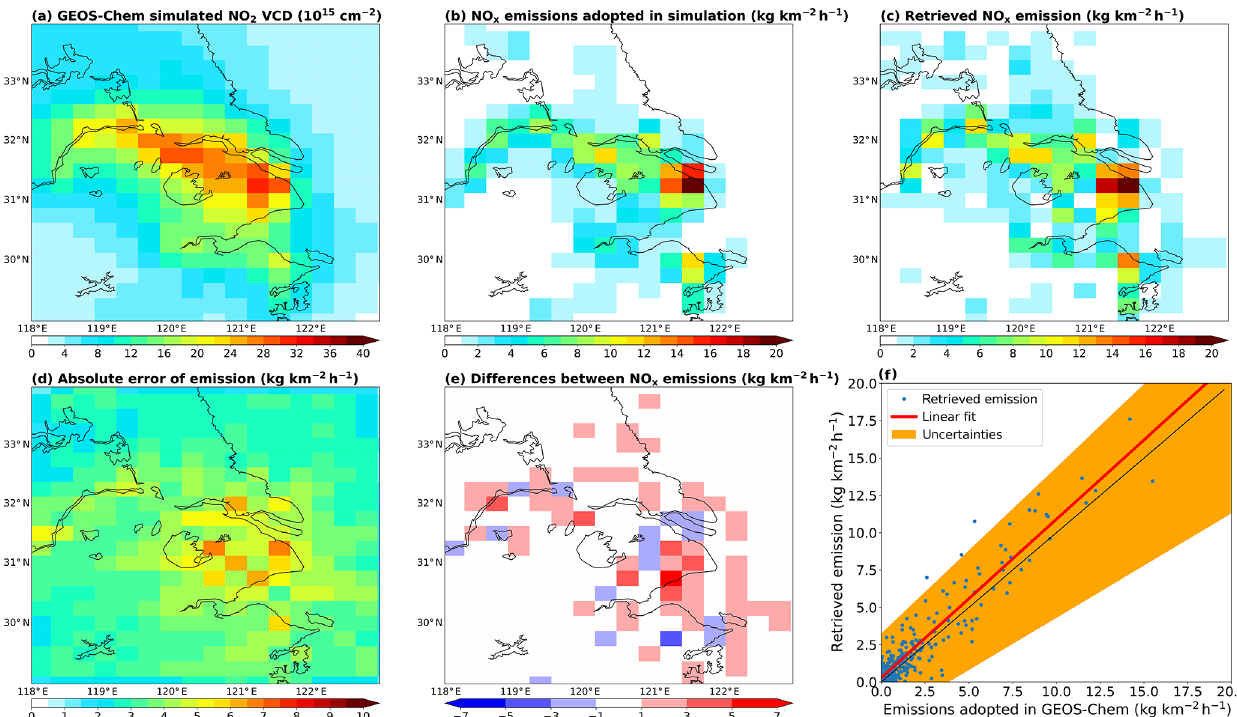
Figure 9. (a) GEOS-Chem-simulated NO 2 VCDs at the 0 . 3125 ◦ × 0 . 25 ◦ resolution for summer 2014. (b) Anthropogenic NO x emissions used in GEOS-Chem. (c) Anthropogenic emissions derived based on GEOS-Chem-simulated NO 2 VCDs and our inversion method. (d) Absolute errors (1 σ ) of derived emission data. (e) Differences between the derived emissions and GEOS-Chem emissions (derived minus GEOS- Chem). (f) Scatter plot for the derived emissions ( y axis) and GEOS-Chem emissions ( x axis). The red line represents least square linear fitting. The shading represents the fitting by accounting for errors in the derived emission data, i.e., derived emissions + 1 σ for the upper bound, and derived emissions − 1 σ for the lower bound. The black dotted line denotes the 1 : 1